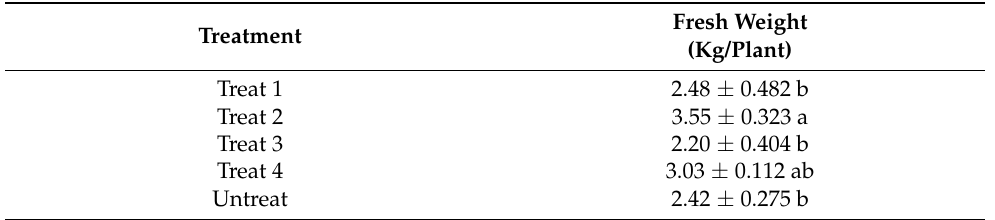
Table 6. Fresh cone yield in the different fertilization treatments. Values followed by the same letter indicate no significant differences ( p <